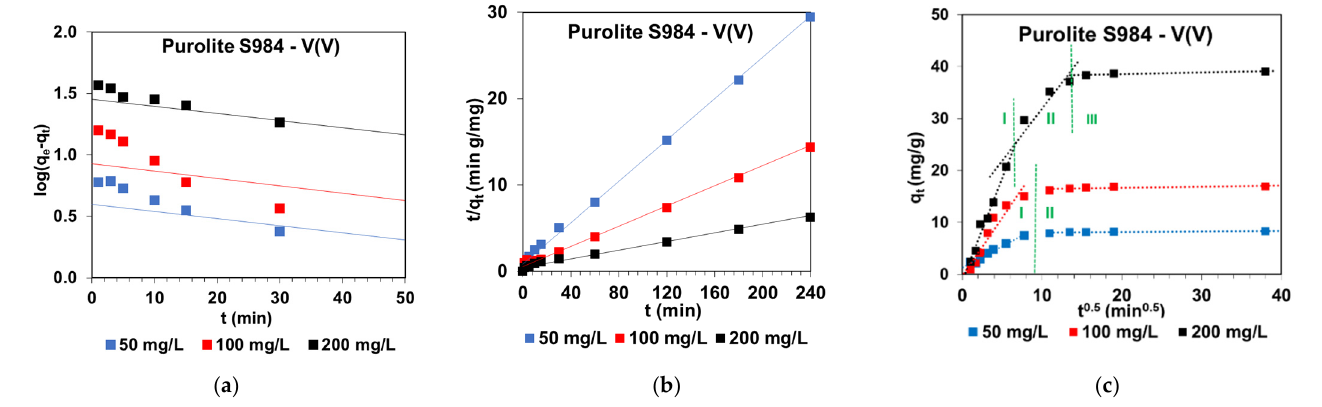
Figure 9. Examples of ( a ) PFO, ( b ) PSO, and ( c ) IPD plots obtained during the V(V) adsorption on Purolite S984.